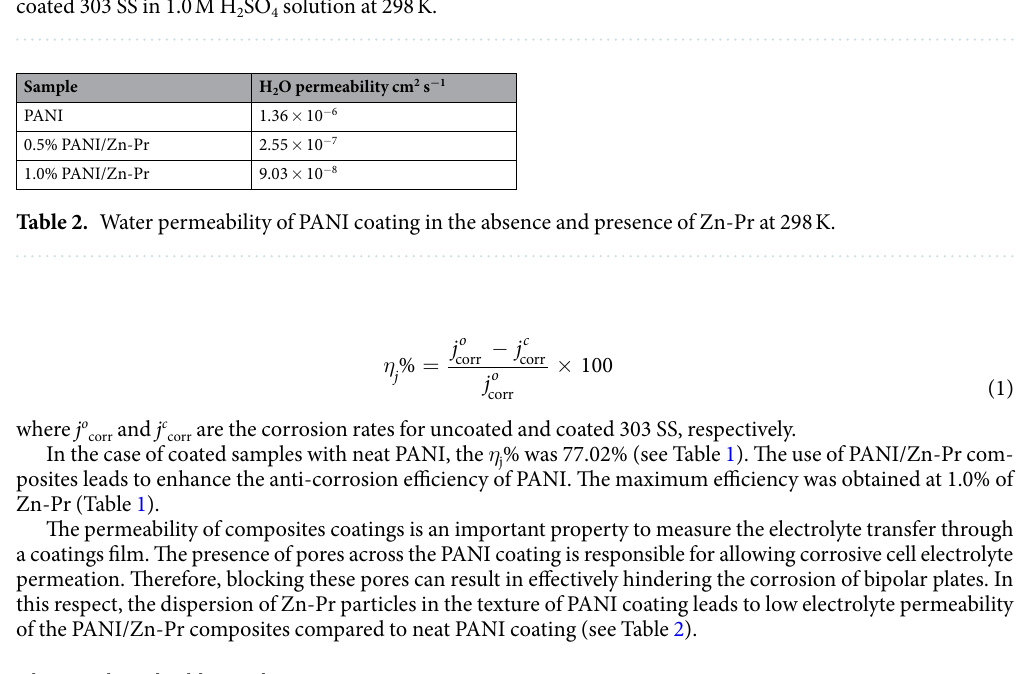
Table 1. Electrochemical parameters and the corresponding corrosion inhibition efficiency for uncoated and coated 303 SS in 1.0 M H 2 SO 4 solution at 298 K.